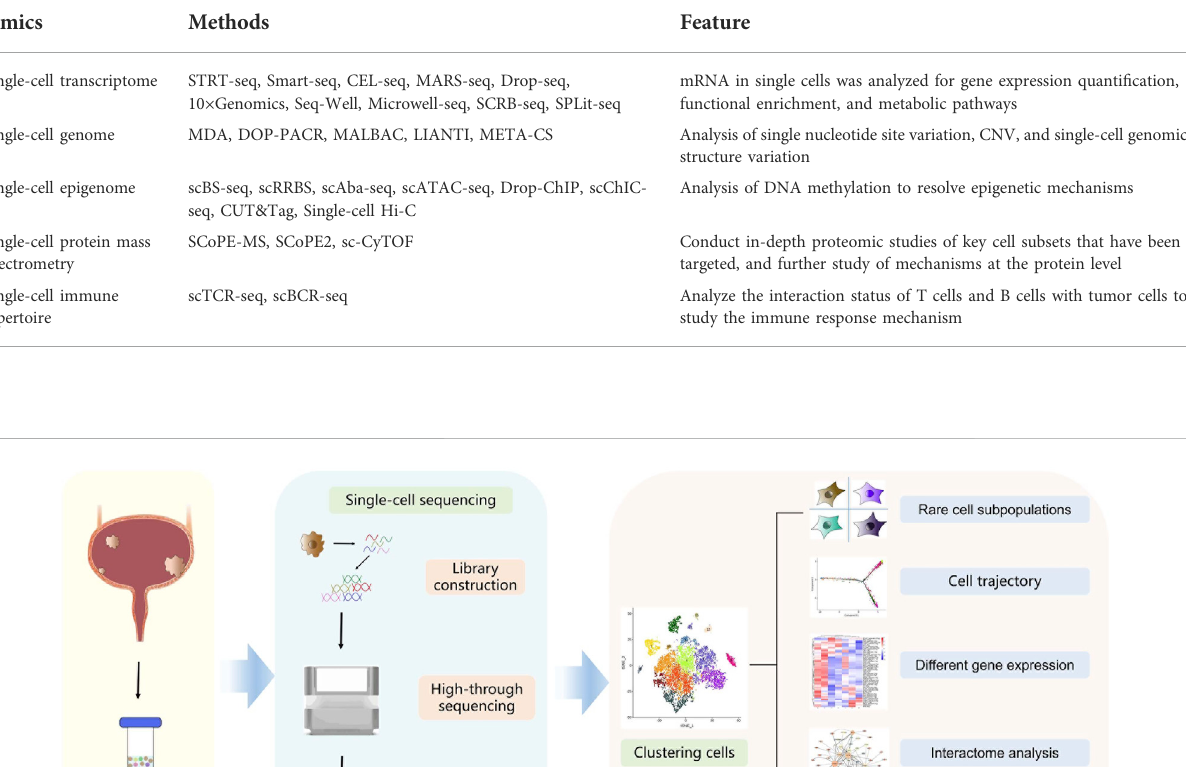
TABLE 1 Single-cell omics technologies.